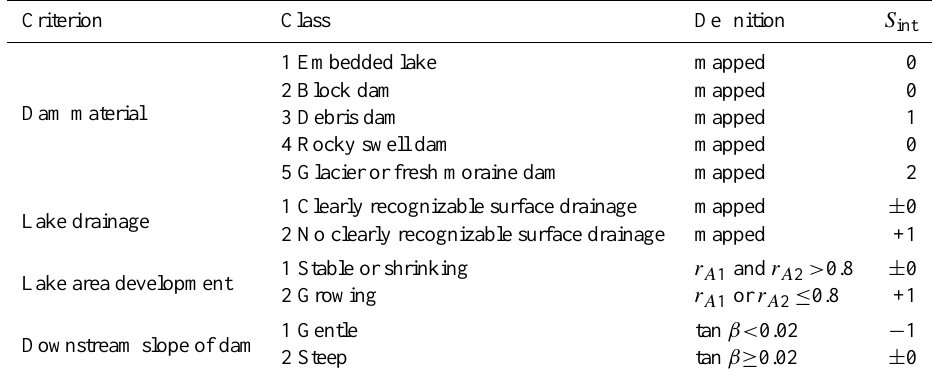
Table 3. Rating scheme for Susceptibility to lake outburst triggered by internal forces S int . Initial values of S int are determined depending on the dam material. These values are then increased or decreased according to lake drainage, lake area development and downstream slope of the dam.